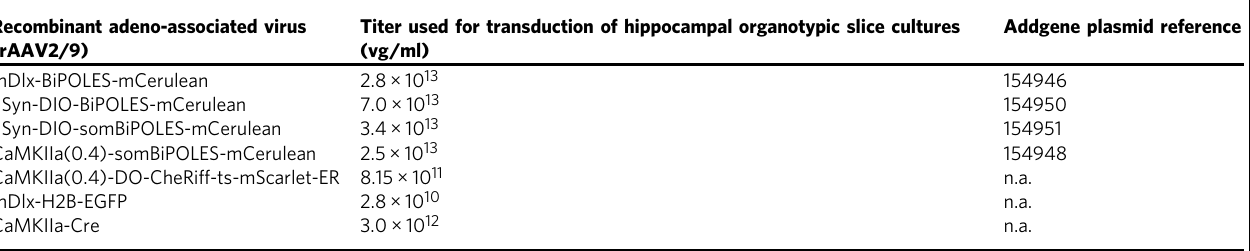
Table 1 List of recombinant adeno-associated viral vectors used for experiments in organotypic hippocampal slices. Recombinant adeno-associated virus (rAAV2/9)